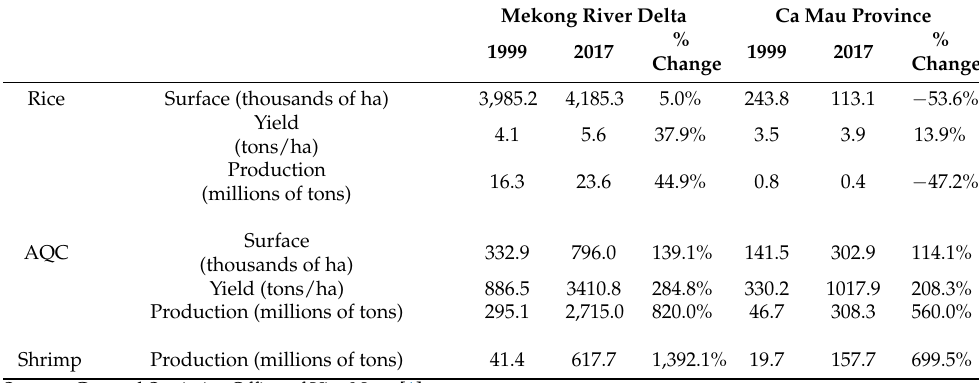
Table 1. Economic Growth in the MRD and Ca Mau,